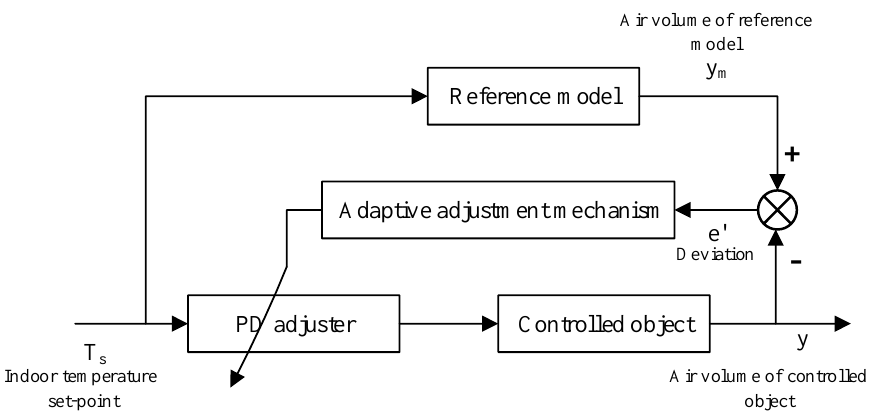
Figure 20. PD gain adaptive regulation model block diagram.